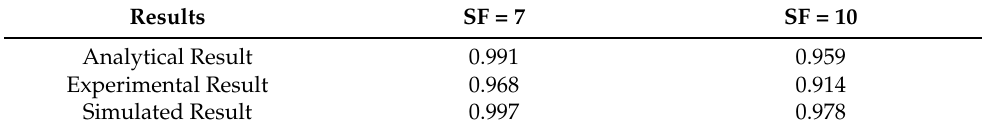
Table 10. Experimental results and comparison with analytical, simulated and experimental